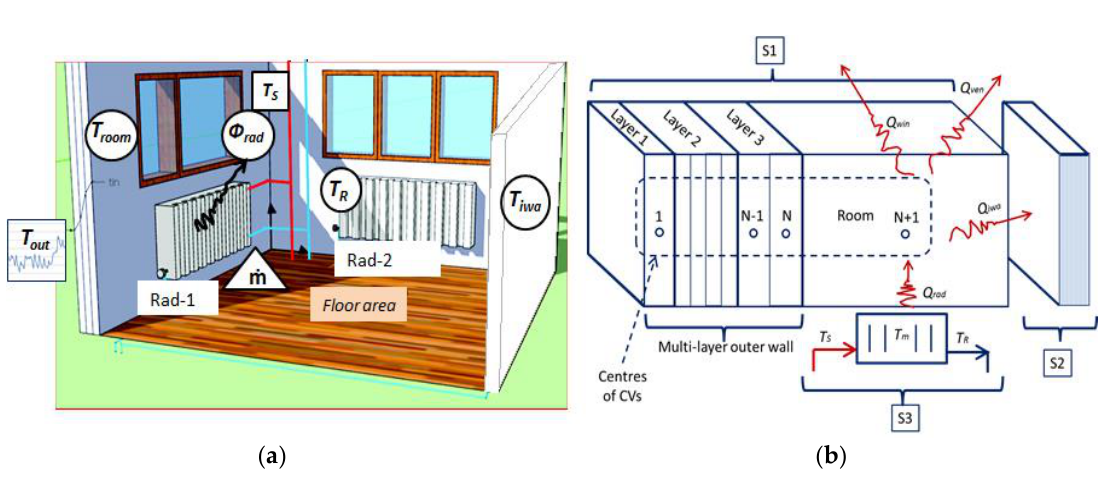
Figure 1. ( a ) Physical domain of the model room; ( b ) Calculation domain